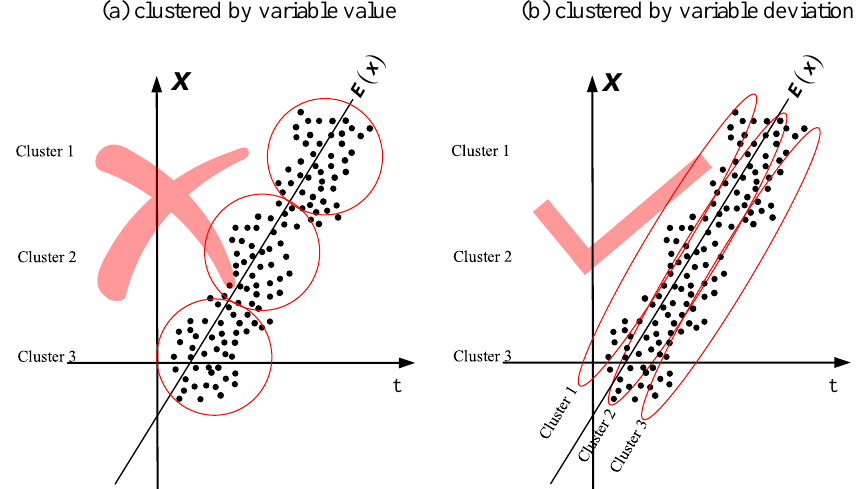
Figure 2. Cluster results for dynamic static process: ( a ) clustered by variable value and ( b ) clustered by variable deviation.